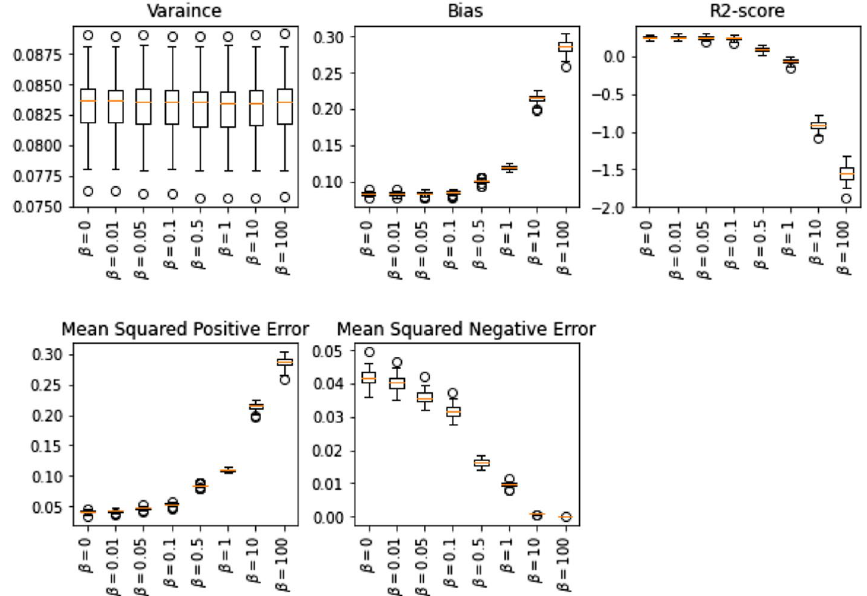
Fig. 3 The effect of hyperparameter β on variance, bias, and score of multivariate Support Vector Machine